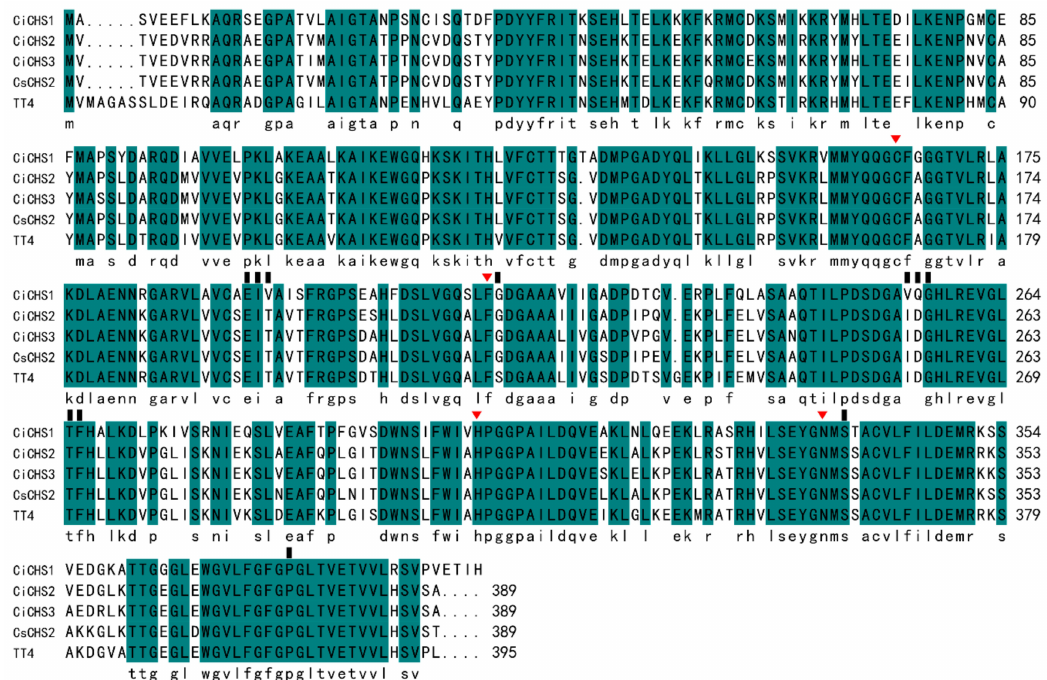
Figure 3. Multiple alignment of five CHSs: CiCHS1, CiCHS2, CiCHS3, TT4 (AT5G13930), and CsCHS2 (P48387.1). The red triangles indicate the positions of active sites. The black squares indicate the positions of product binding